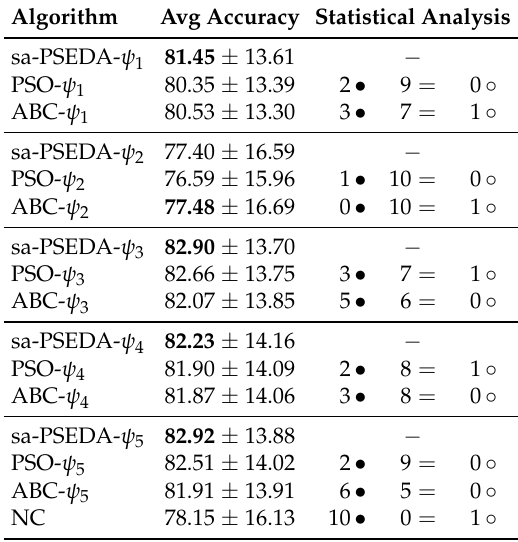
Table 3. Average accuracy ± standard deviation and statistical analysis [42] for the 15 SI classifiers and the NC classifier over the 11 classification